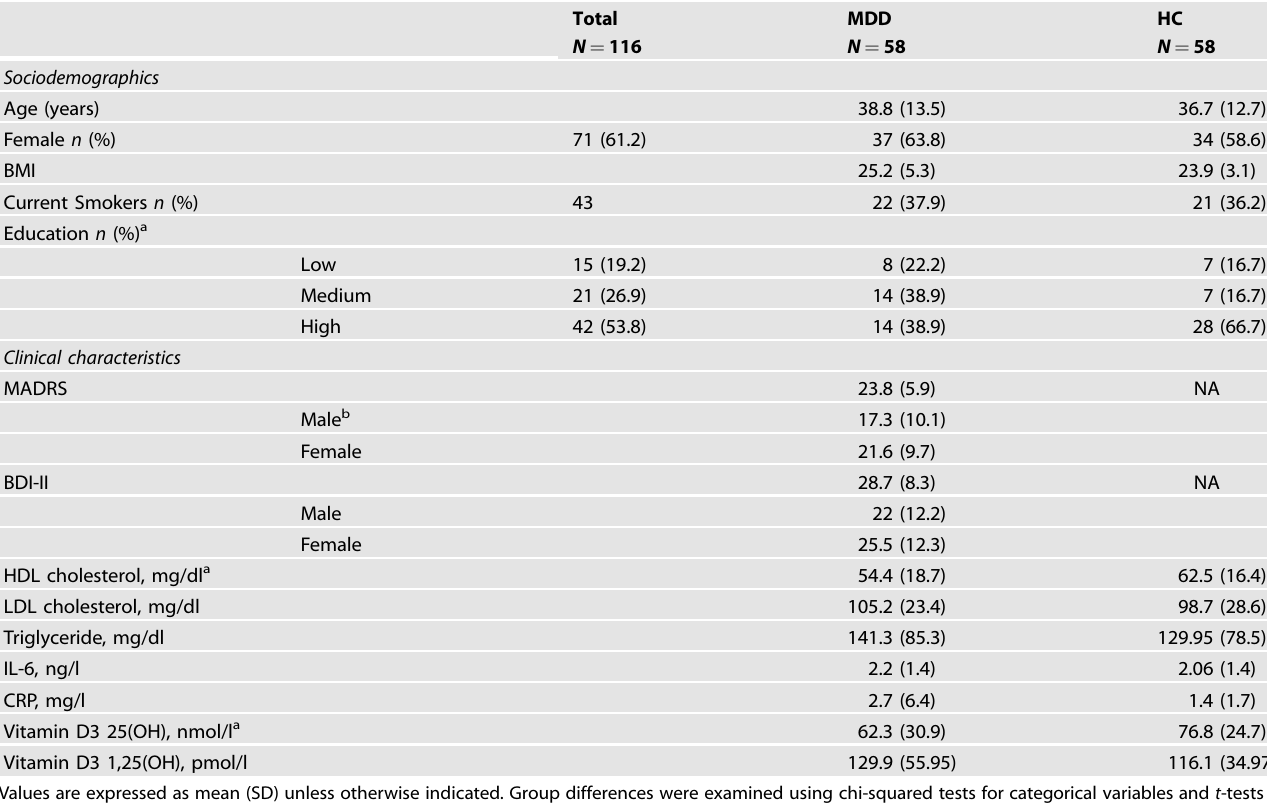
Table 1. Participant